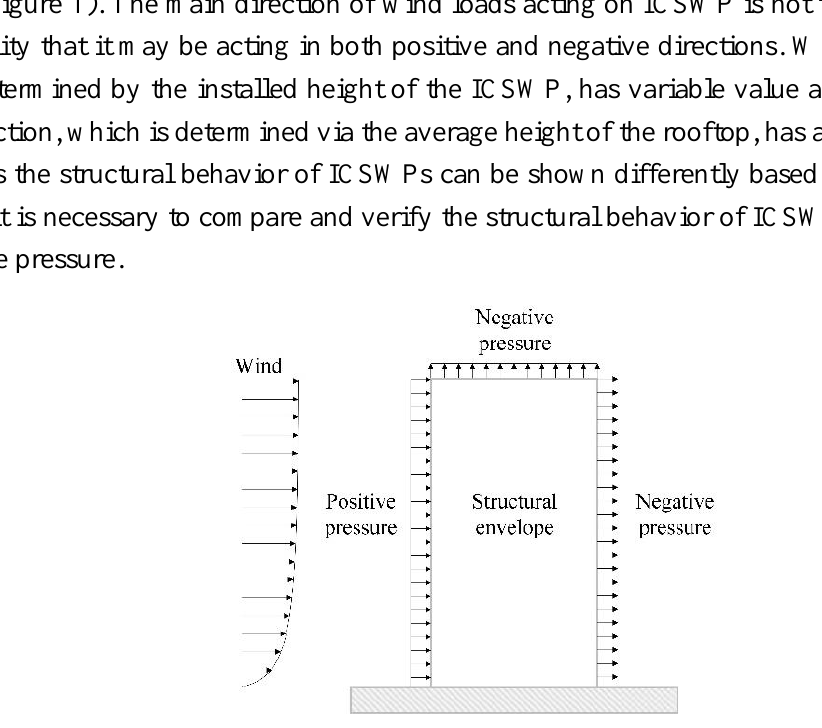
Figure 1. Effects of positive and negative pressure on the exterior wall of the